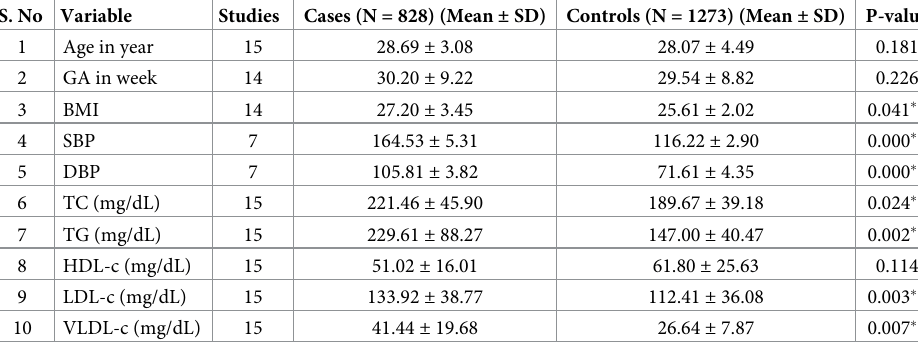
Table 2. Paired sample test analysis of variables in PE and normotensive pregnant women. S. No Variable